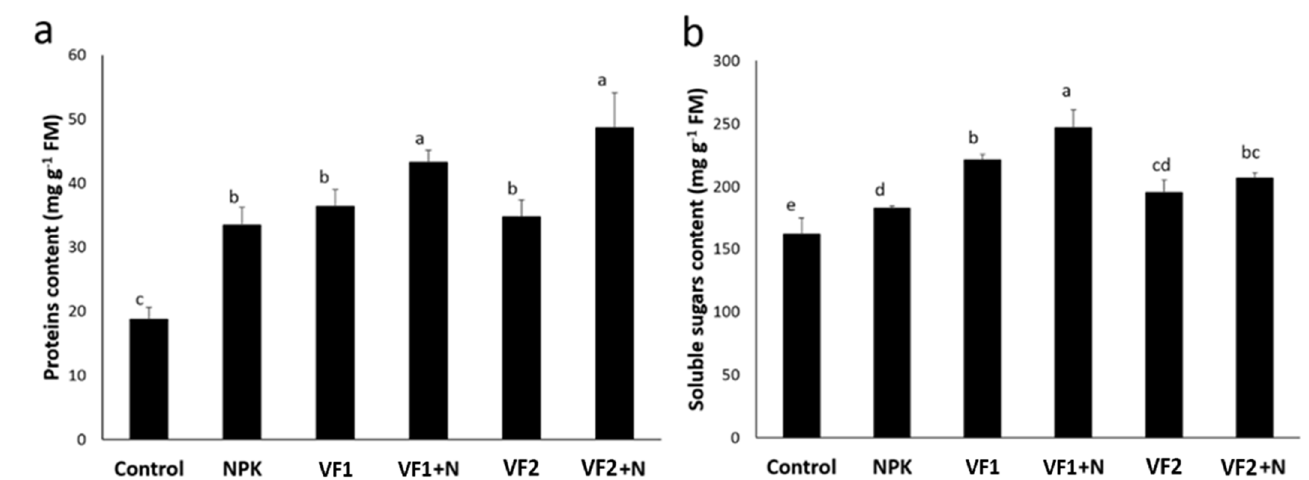
Figure 9. Fruit total soluble proteins ( a ) and sugars ( b ) content of tomato treated with vitreous and chemical fertilizers in open field. NPK: conventional fertilizer; VF1: formula 1 of the vitreous fertilizer, VF2: formula 2 of the vitreous fertilizer; N: Nitrogen. Bars with different letters are significantly different according to Tukey’s HSD test after performing one-way ANOVA ( p < 0.05).